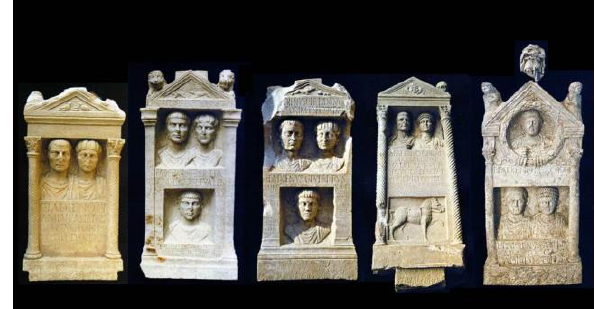
Figure 4. The stele of Fadieni (Berti, 2006).